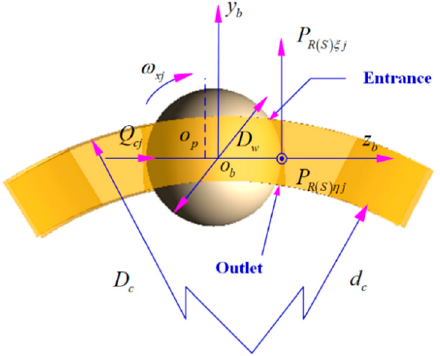
Figure 8. Forces between the j th ball and the cage.